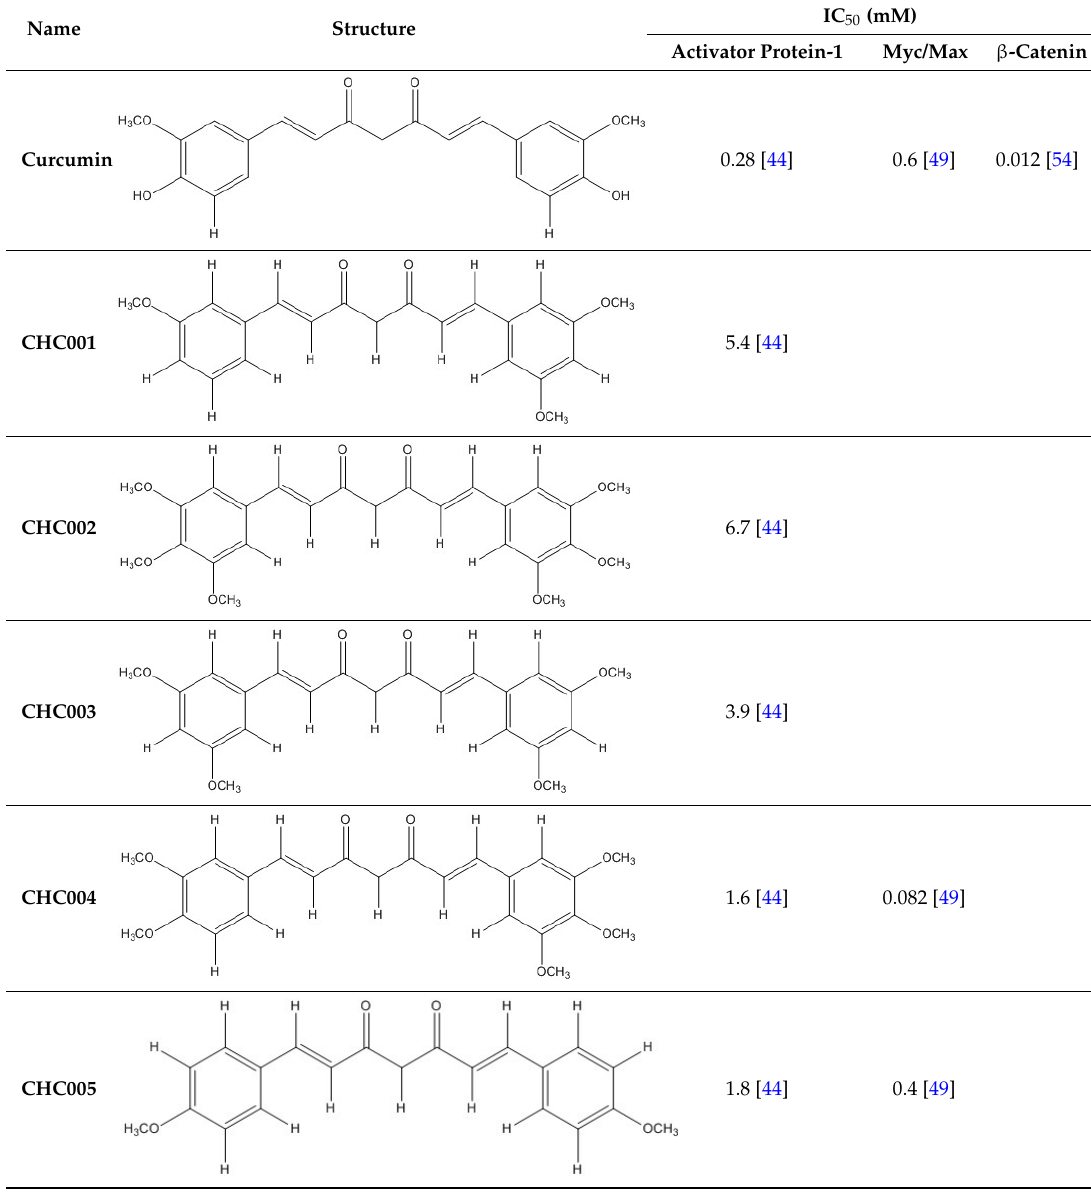
Table 2. Structures and activities of curcuminoid inhibitors against transcription factors.